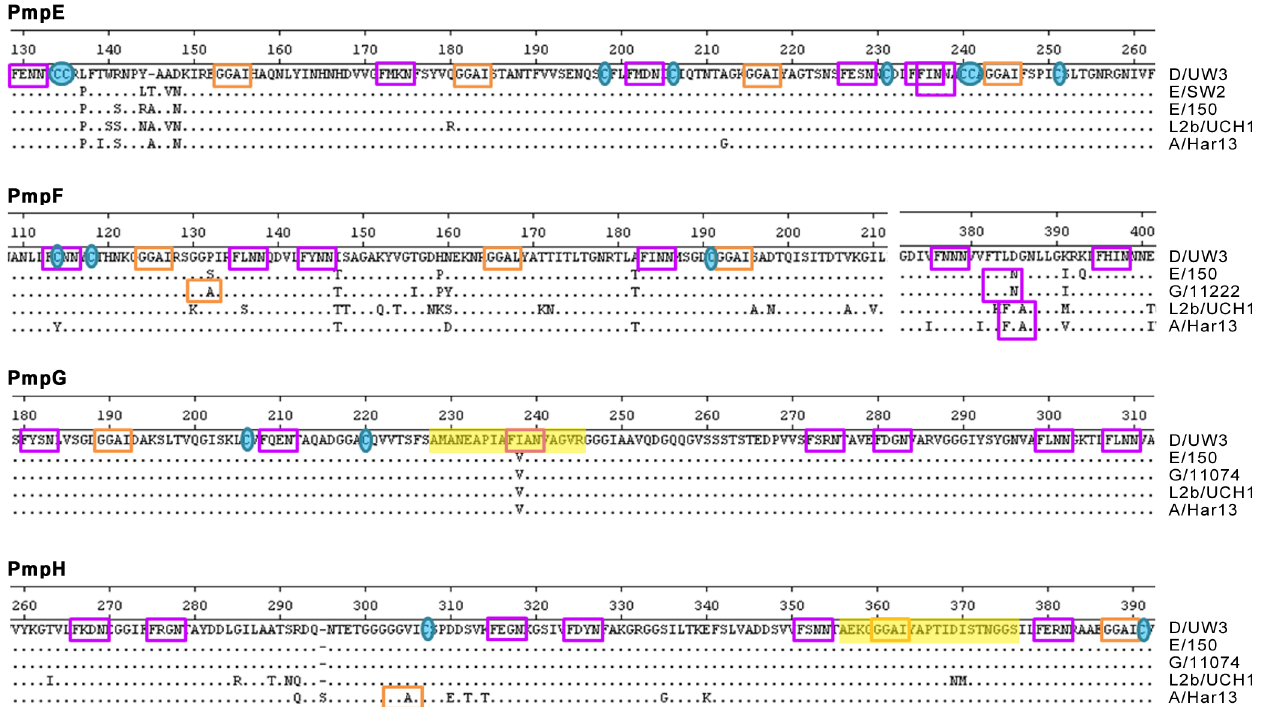
Fig 3. Pmp alignments showing examples of protein regions containing high concentration of FxxN motifs (purple), GGA(I, L) motifs (orange), and cysteine residues (blue). MHC class II (I-Ab)-bound C . trachomatis peptides are highlighted in yellow.